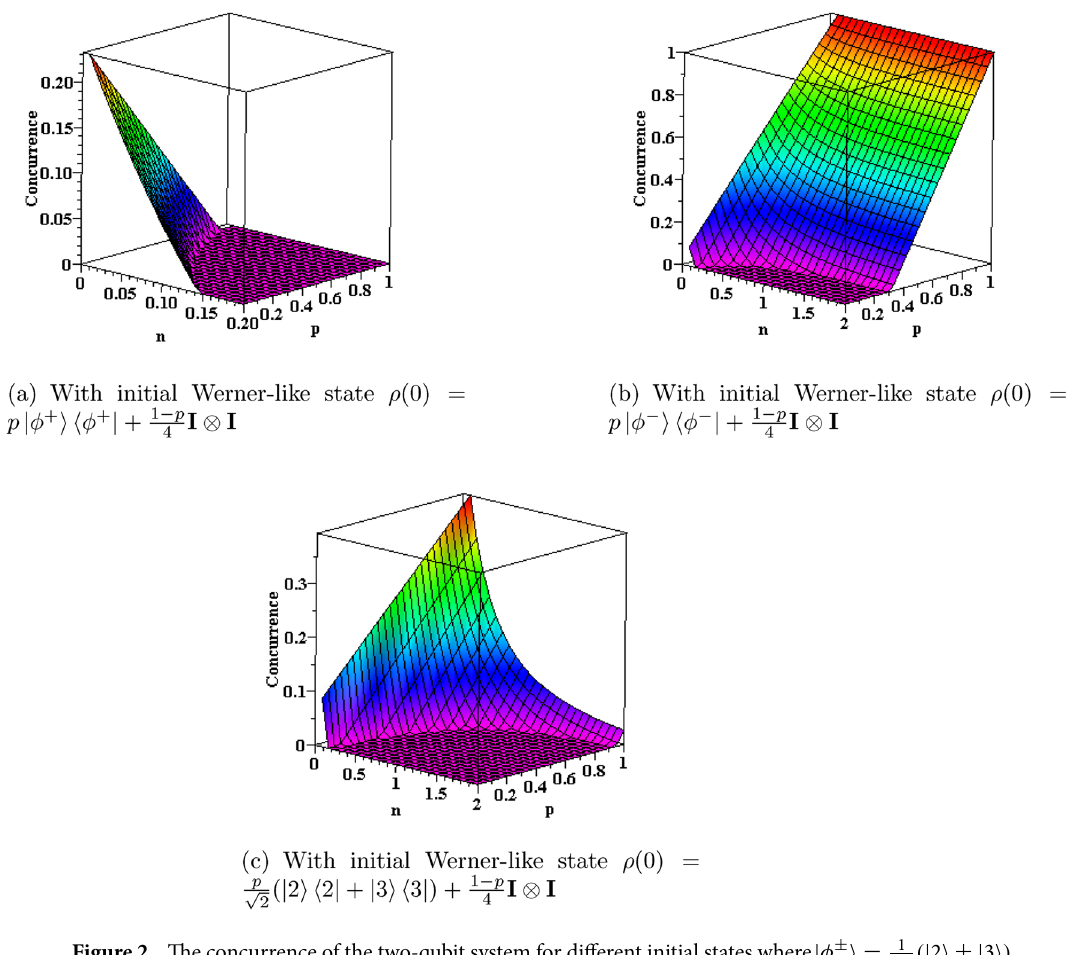
Figure 2. The concurrence of the two-qubit system for different initial states where